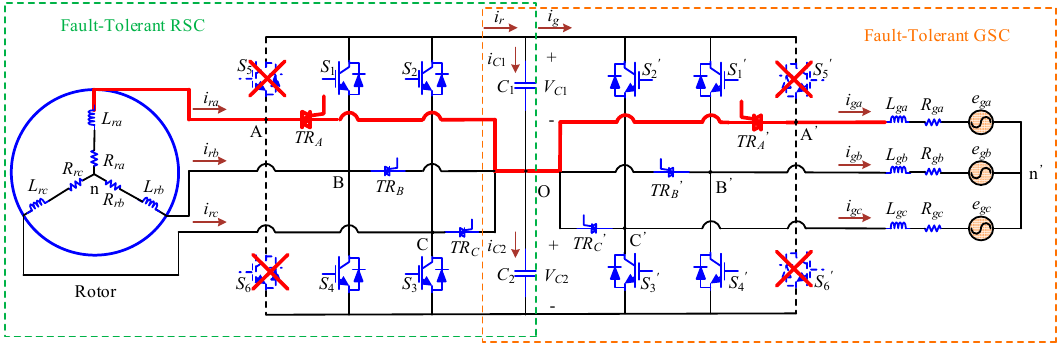
Figure 4. Reconfiguration from the six-switch three-phase (SSTP)- to FSTP-based back-to-back (BTB) converter topology.